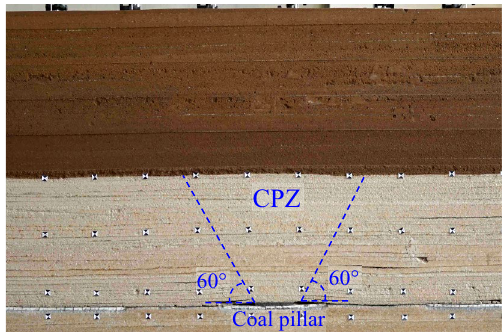
Figure 5. Strata subsidence in CPZ.